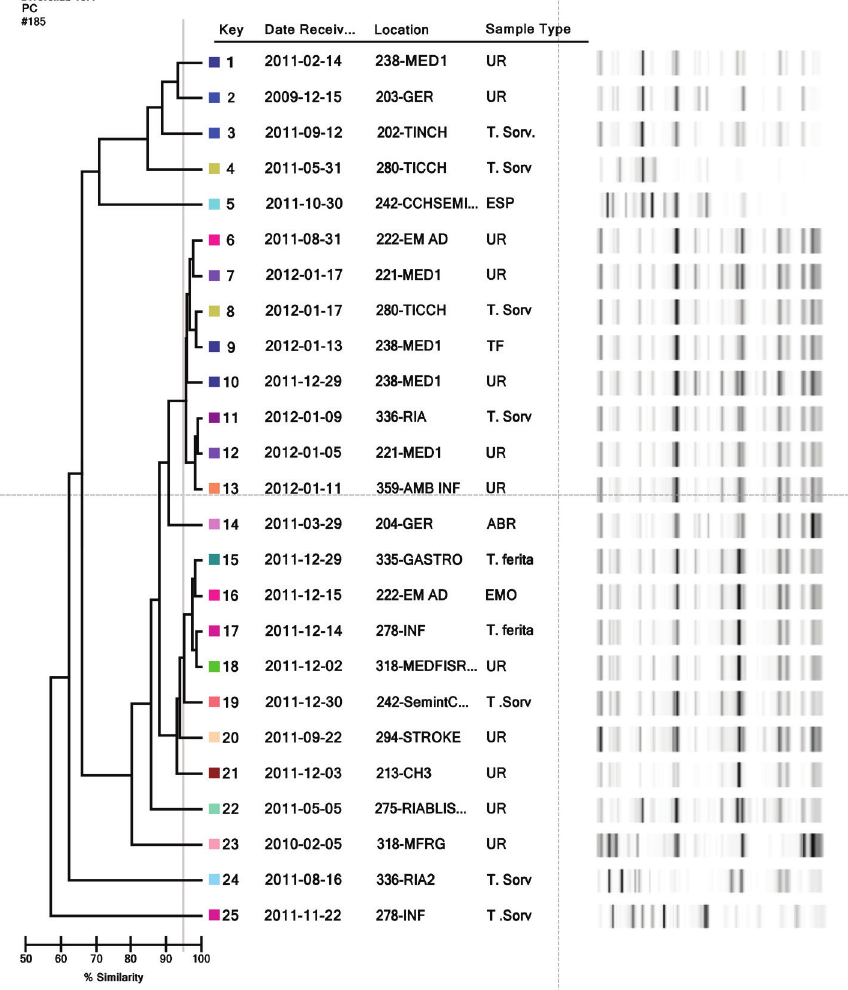
Supplementary Figure 1. The dendogram